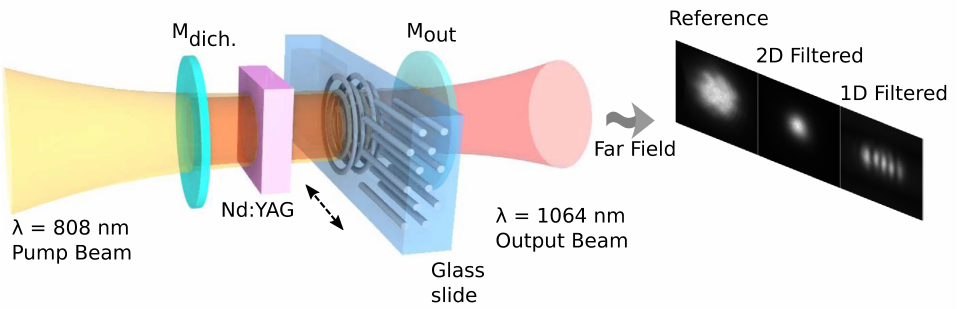
Figure 5. Principle of transverse mode filtering in microchip laser by application of laser-made photonic crystal embedded in a glass chip. The solution is compact and allows to achieve a high degree of control over the spatial characteristics of a laser, depending on the geometry of inserted element. Adopted from